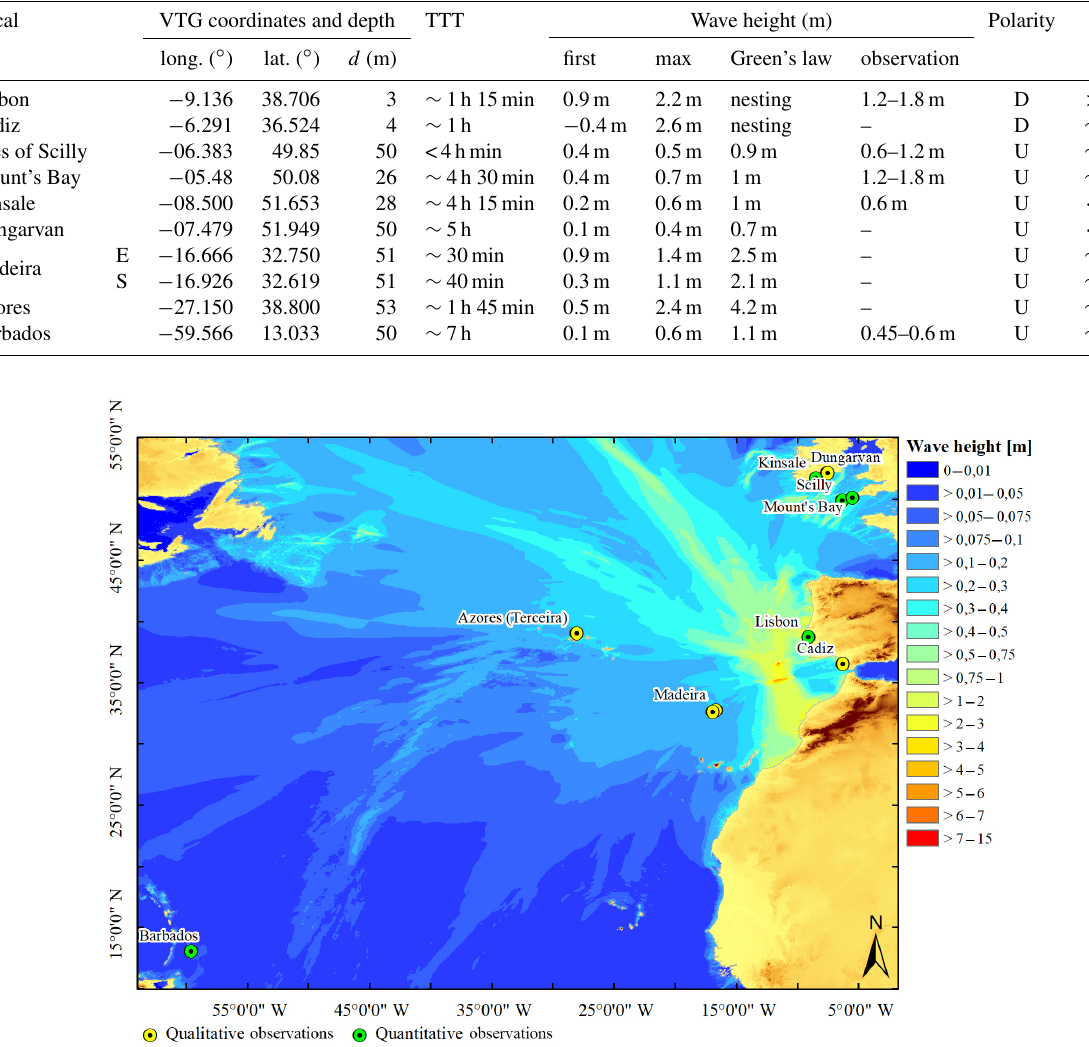
Figure 4. Maximum wave height distribution (colour scale in metres) in the Atlantic basin produced by the source of hypothesis A-MS.